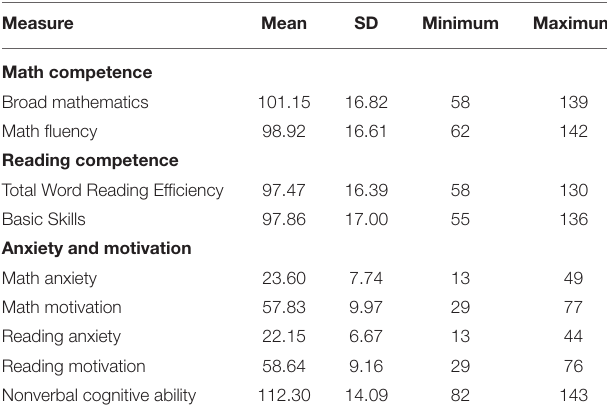
TABLE 1 | Descriptive statistics for reading and mathematics competence, and reading and mathematics motivation and anxiety ( n =